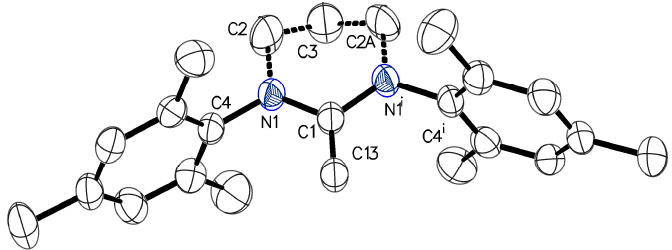
Figure 5. Molecular structure of (6-Mes)=CH 2 with thermal ellipsoids at 50% probability level. Selected bond lengths [Å] and angles [°]: C(1)–N(1) 1.3875(18), C(1)–C(13) 1.336(3), C(1)–N(1)–C(13) 122.43(10).